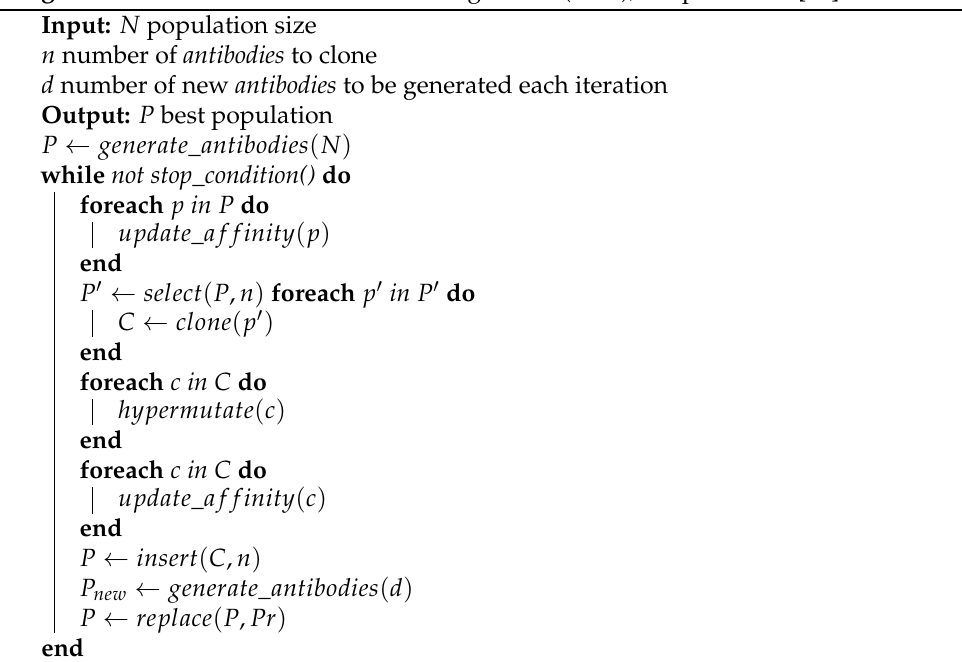
Algorithm 2: General Clonal Selection Algorithm (CSA), adapted from